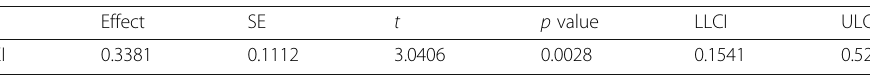
Table 5 Total effects of PEE on